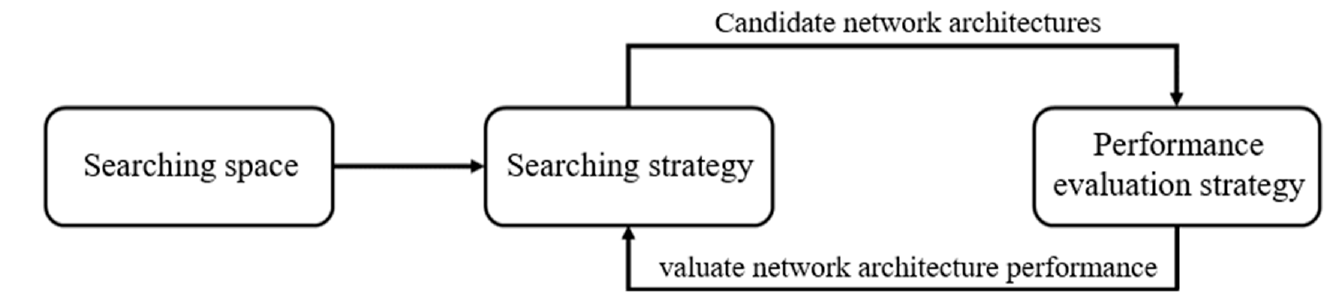
Figure 6. Three components of Google’s NAS system.